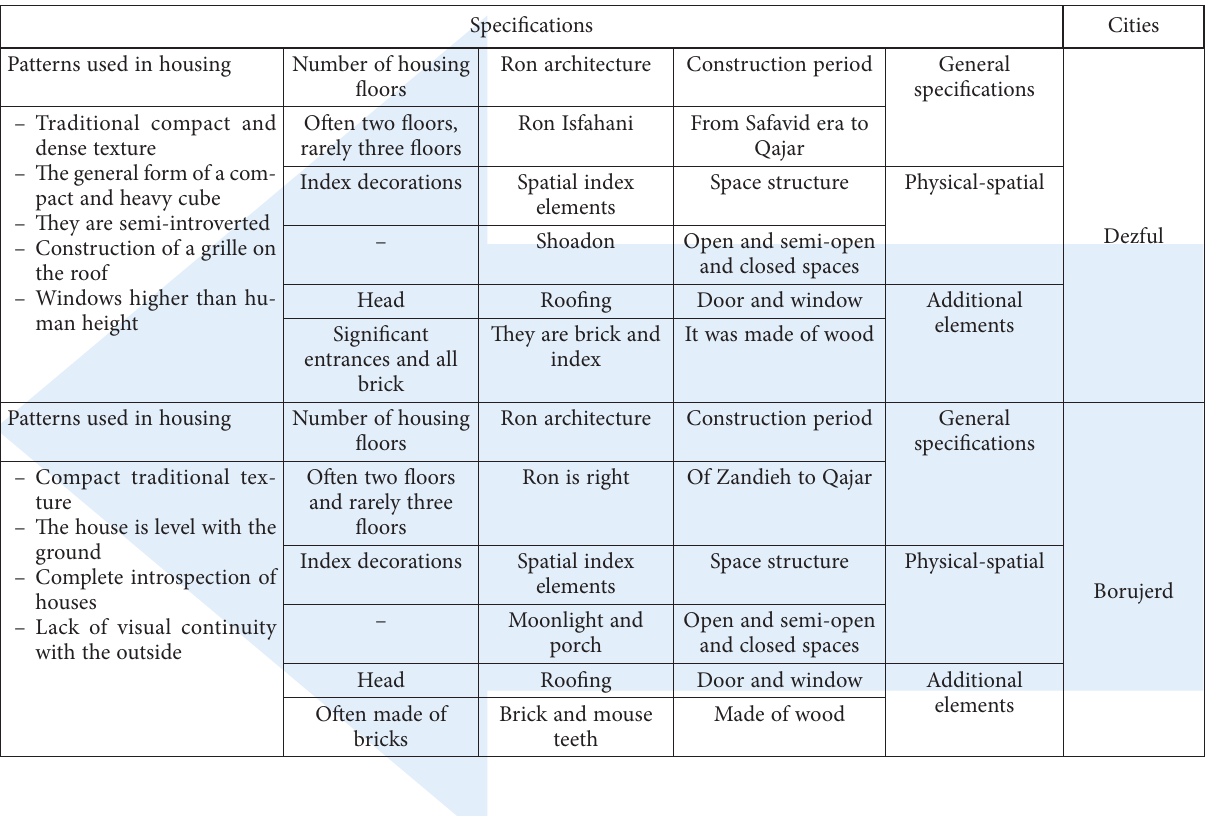
Table 3. Physical knowledge of traditional housing texture in Dezful and Boroujerd (source: compiled by the authors)